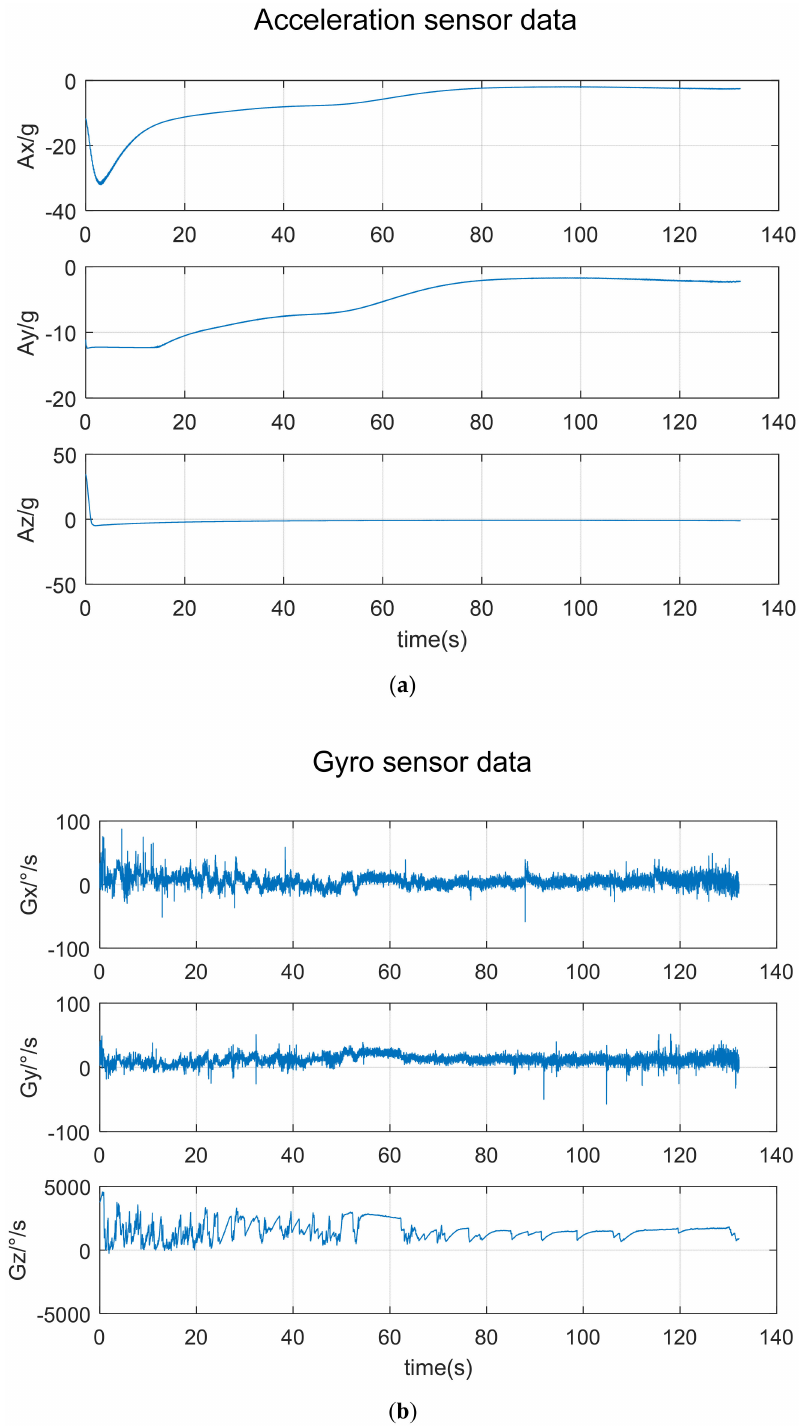
Figure 9. Delay time between recording and impact detecting. ( a ) Three-axis accelerometer data; ( b ) Three-axis gyro